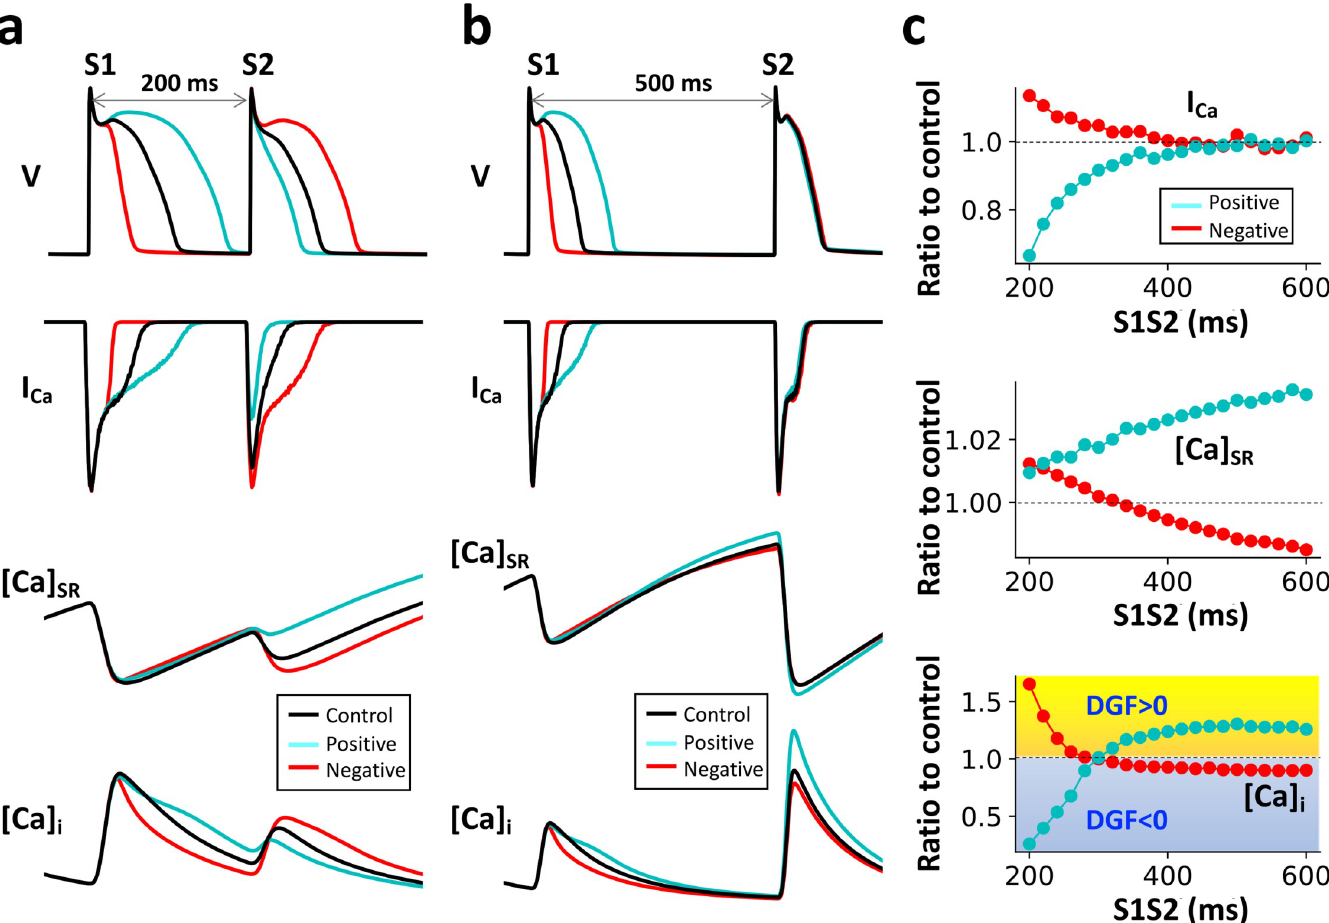
Fig 6. Relationship between the Ca 2+ -to-APD coupling properties and DGF. a. Time traces of voltage, I Ca , SR Ca 2+ , and cytosolic Ca 2+ for control (black), enhanced positive coupling in the S1 beat (cyan) and enhanced negative coupling in the S1 beat (red). S1S2 = 200 ms. b. Same as in a. but S1S2 = 500 ms. c. Ratios of I Ca peak, SR Ca 2+ load, and [Ca 2+ ] i peak on the S2 beat under positive (cyan) or negative (red) coupling conditions to the corresponding quantities at control v.s. S1S2 interval. Here, α nsCa = 0 for all the cases. In the S1 beat, α SK is 5, 0, and 30 for control, enhanced positive, and enhanced negative cases, respectively. In the S2 beat, α SK is 5 for all the cases.